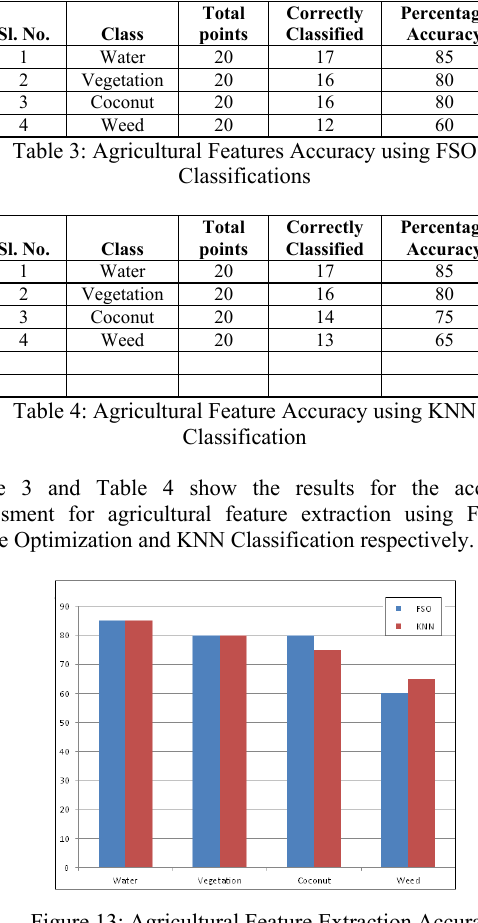
Figure 13: Agricultural Feature Extraction Accuracy Assessment Bar